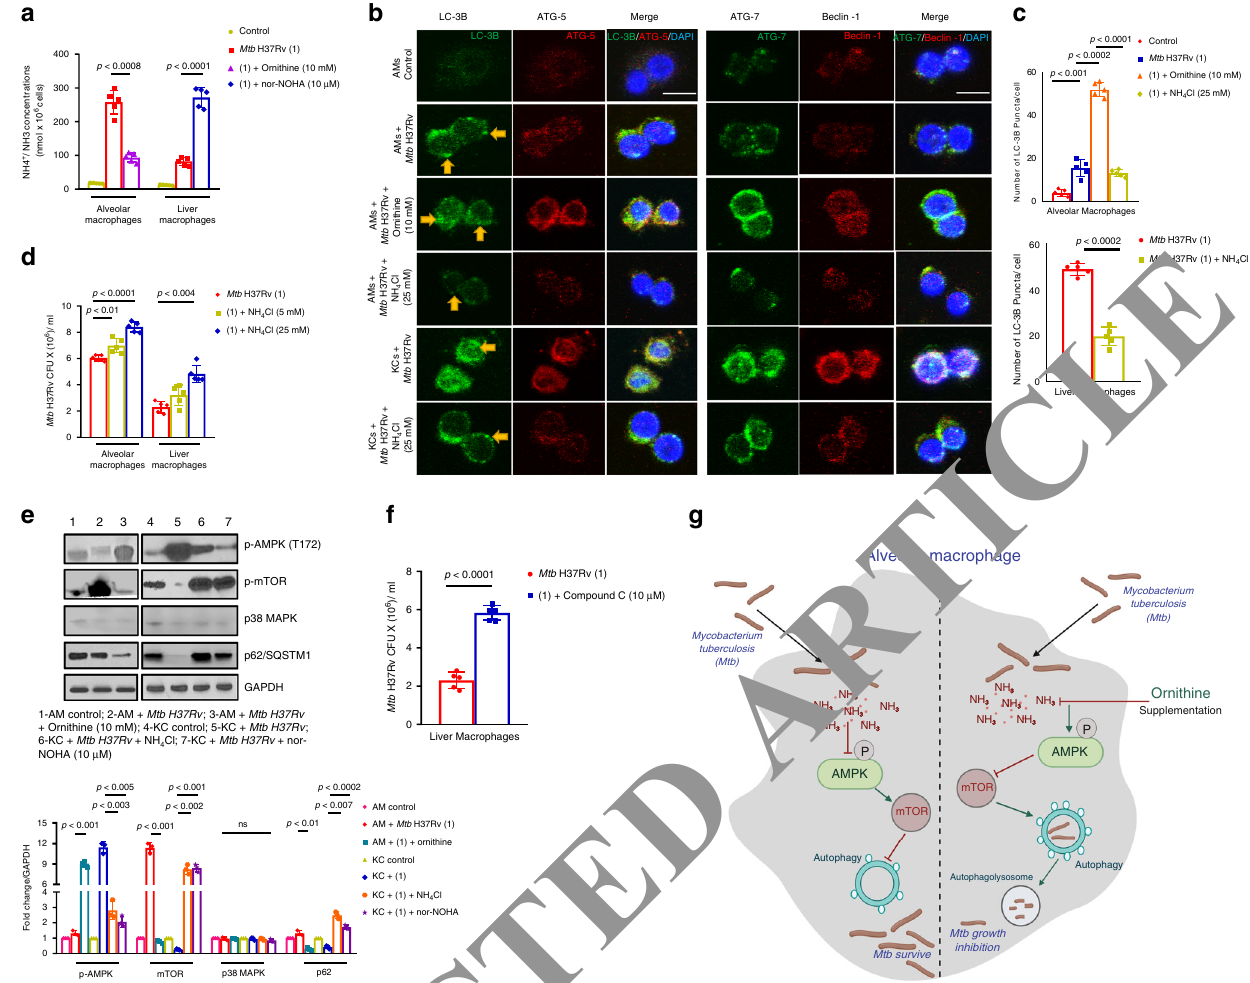
Fig. 6 Ornithine limits ammonia and activates AMPK. AMs and KCs from C57BL/6 mice were isolated and infected with Mtb H37Rv at an MOI of 1:2.5. After 72 h. a NH 4 + /NH 3 levels were measured in the cell lysates treated with ornithine or nor-NOHA (arginase inhibitor) by spectrophotometric analysis at 570 nm with extrapolation from the standard curve and expressed in nmol (mean ± SD). Data are representatives of fi ve independent experiments. b A representative micrograph of LC3-B, ATG-7, ATG-5 and Beclin-1 in AMs treated with ornithine or NH 4 Cl and KCs treated with NH 4 Cl at respective concentrations. Blue: DAPI; green: LC-3B and ATG-7; red: ATG-5 and Beclin-1. Scale bar: 5 μ m. Images of multiple fi elds at 63× magni fi cation were taken with oil immersion. c The number of LC-3B puncta relative to the cell area (10 cells per condition) was quanti fi ed using ImageJ. p < 0.0012. d At 2 h post- infection, NH 4 Cl was added at the indicated concentrations. Intracellular CFUs were demonstrated after 5 days of infection. p < 0.0195, p < 0.0042. n = 5 experiments. e Total protein was extracted from the above cells and western blotting was performed. A representative blot depicting the levels of p-AMPK, p-mTOR, p38 MAPK, LC-3 and p62/SQSTM1 in the control, ornithine or NH 4 Cl treated and Mtb H37Rv-infected macrophages is shown. Normalized fold intensities of p-AMPK, p < 0.0013, p < 0.0032, p < 0.0051; p-mTOR, p < 0.0017, p < 0.0027, p < 0.0018; p38 MAPK, ns not signi fi cant; and p62 levels p < 0.0191, p < 0.0072 in Mtb -infected and ornithine or NH 4 Cl treated macrophages compared with the levels in the uninfected control. n = 3 experiments. f At 2 h post-infection, ornithine and compound C were added at indicated concentrations. Intracellular CFUs were demonstrated after 5 days of infection. n = 5 experiments. Data are presented as the mean ± SD and analyzed using paired two-tailed t test. g Schematic representation of ornithine restricting Mtb growth in AMs. Red color indicates inhibitory line and green arrows indicates activation.